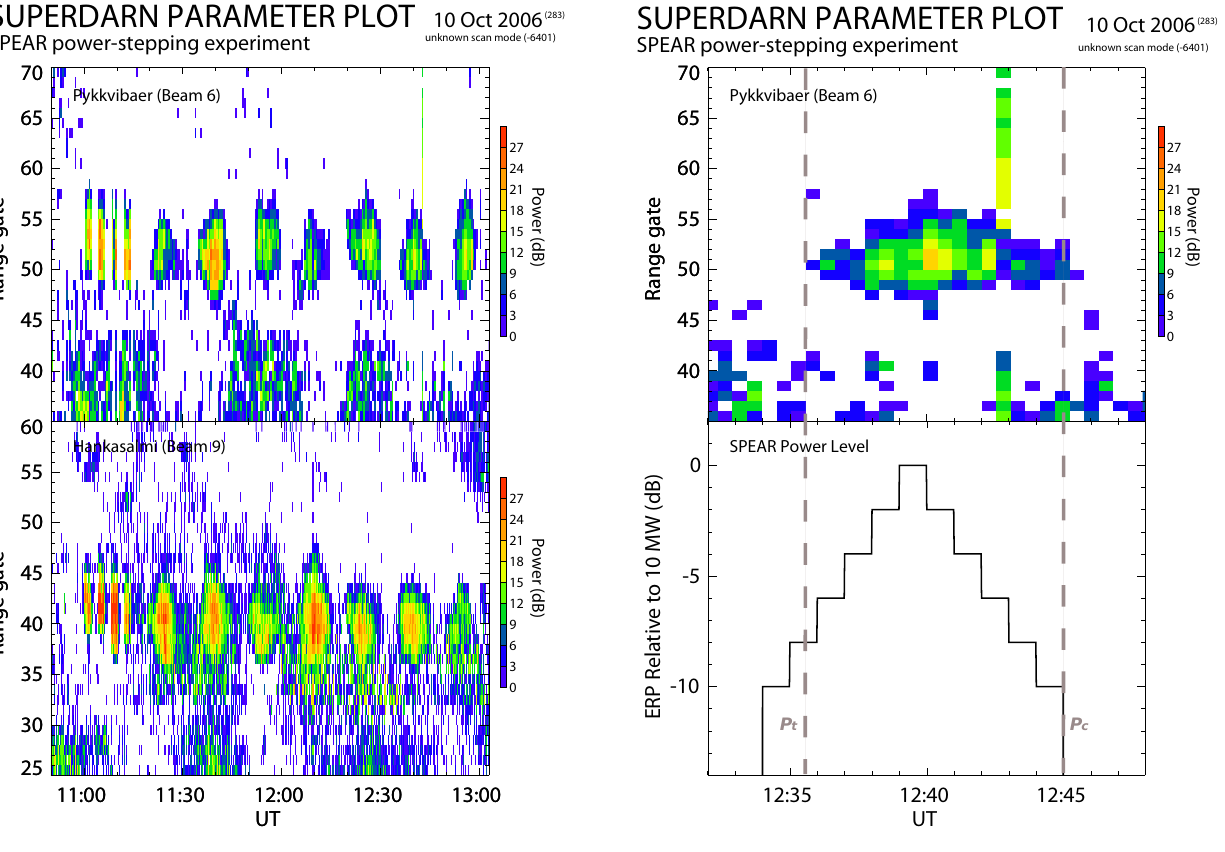
Fig. 5. Backscatter power (pwr_l) measurements from the CUT- LASS Þykkvibær radar (upper) during one power stepping cycle on 10 October 2006. The SPEAR output power during the interval is shown in the lower